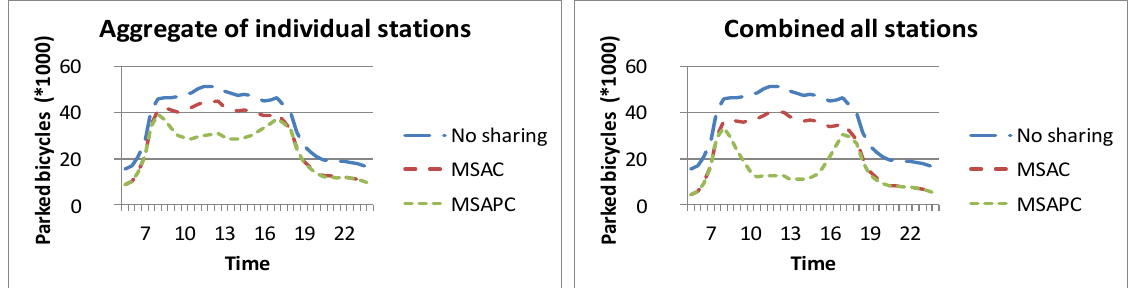
Figure 5. Distribution of parked bicycles over time for different sharing cases, central stations of other large